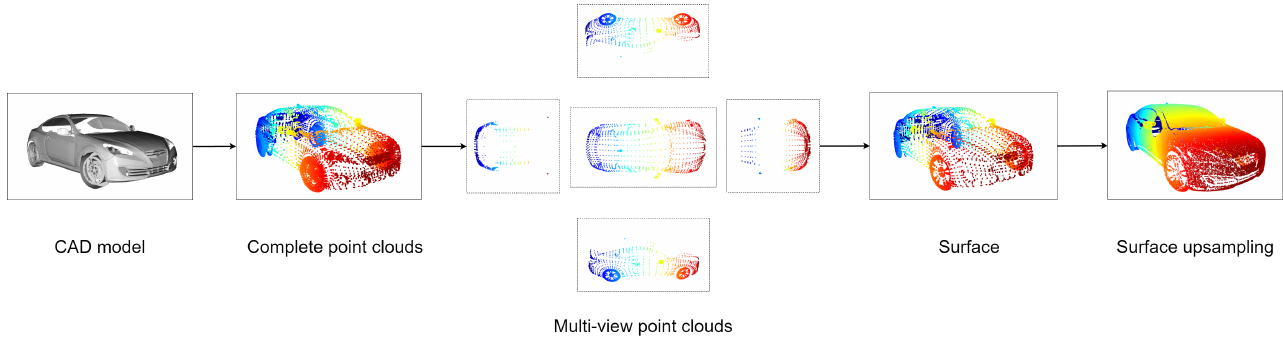
Figure 4. The illustration of our surface point sampling method.